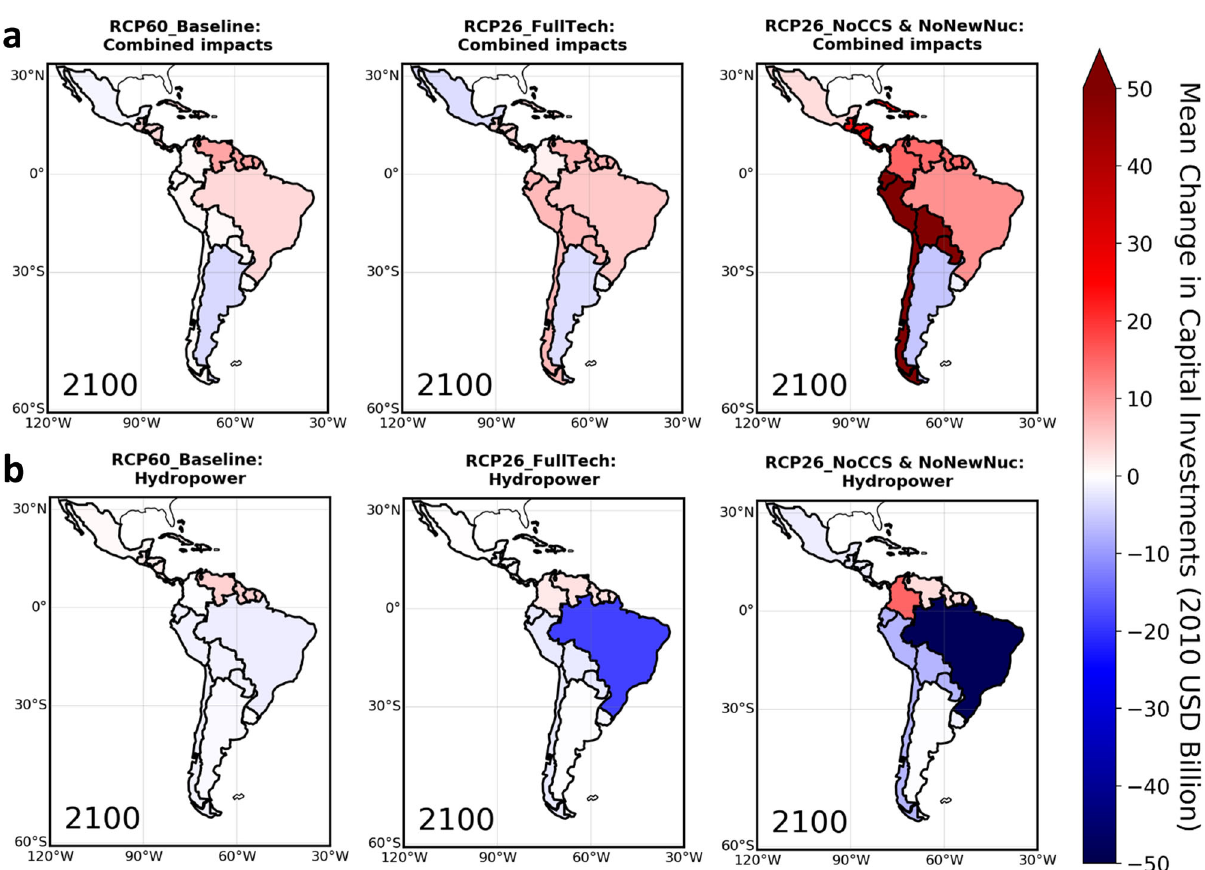
Fig. 2 Model mean changes in total capital investment requirements in LAC by scenario under distinct assumptions on climate change impacts on renewables. Absolute differences computed under the Combined impacts scenarios ( a ) and Hydropower scenarios ( b ). Changes are calculated using cumulative capital costs (United States dollar – USD) in the 2020 – 2100 period and are relative to the No-Climate impacts scenarios (i.e., positive values mean that scenarios with climate impacts on renewables show increased costs). Full range of estimated costs: USD − 48 to + 54 billion. Results for the period 2020 – 2050 are provided in Supplementary Fig.